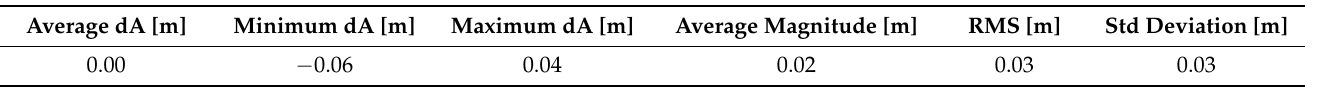
Table 3. Summary of statistical accuracy parameters for height differences. DJI Terra software report (DJI Terra Lidar quality report).